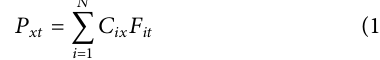
Frontiers in Remote Sensing |